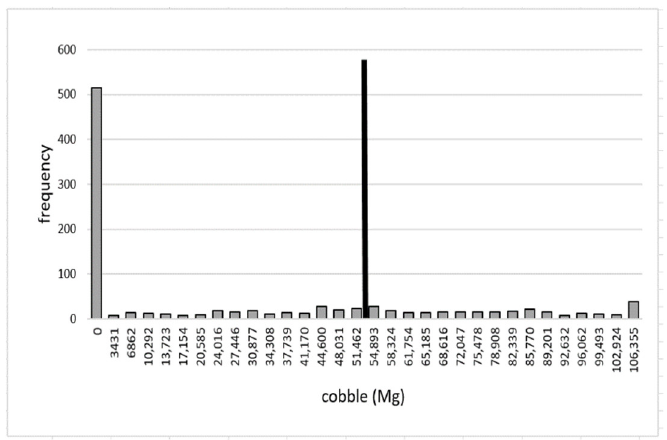
Figure A22. Histogram showing frequencies of achieving given quantity of sales of cobble for mine “G” with σ yprog .